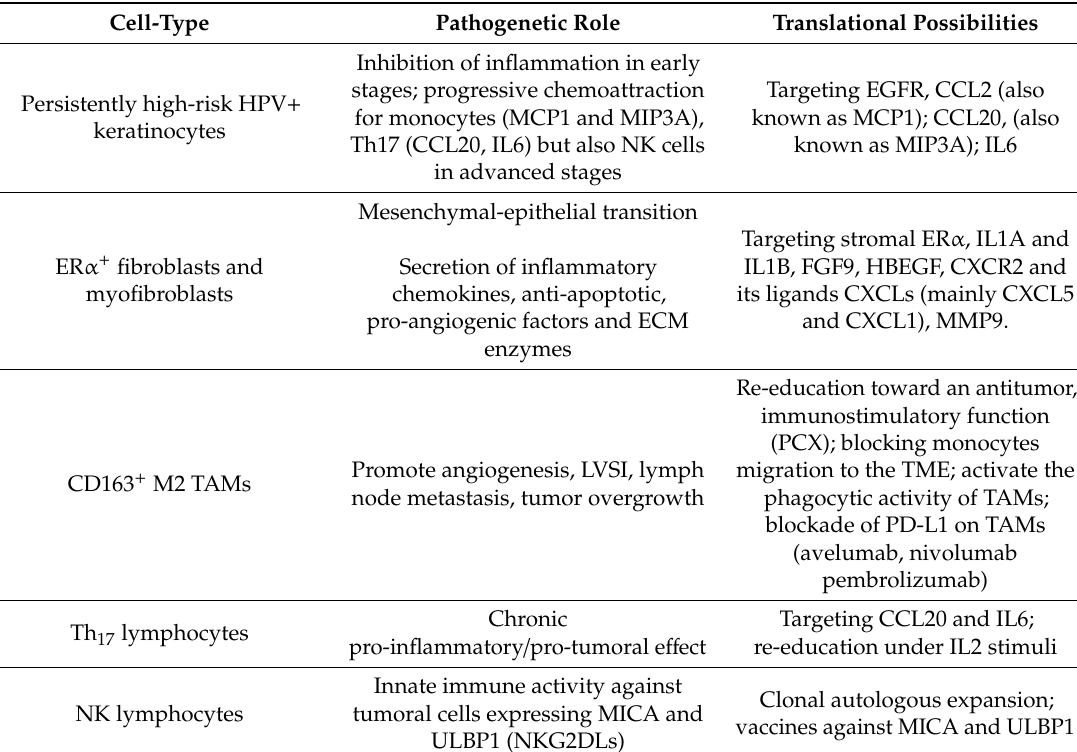
Table 3. Main cell types of the CCx’s TEM, their principal role in CCx pathogenesis and the possible translational